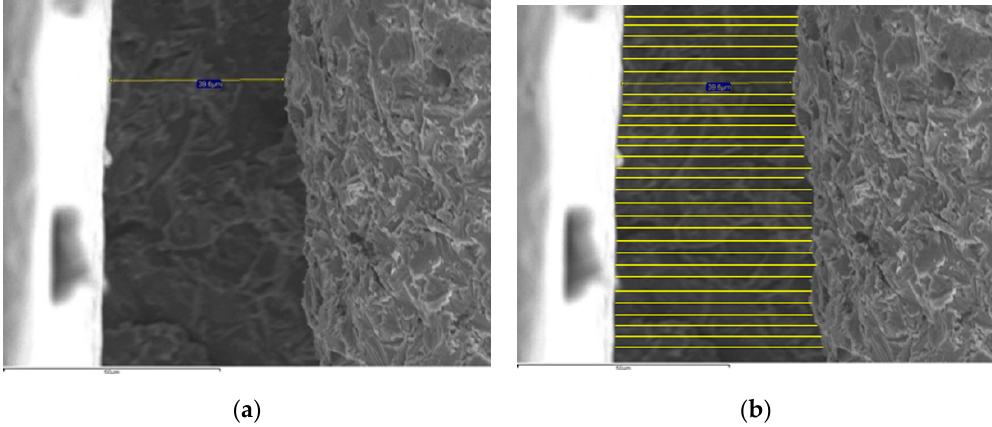
Figure 2. SEM images (1000×): ( a ) PS 10 L specimen, ( b ) Detail of the edited ( a ) image increasing the number of measurements.